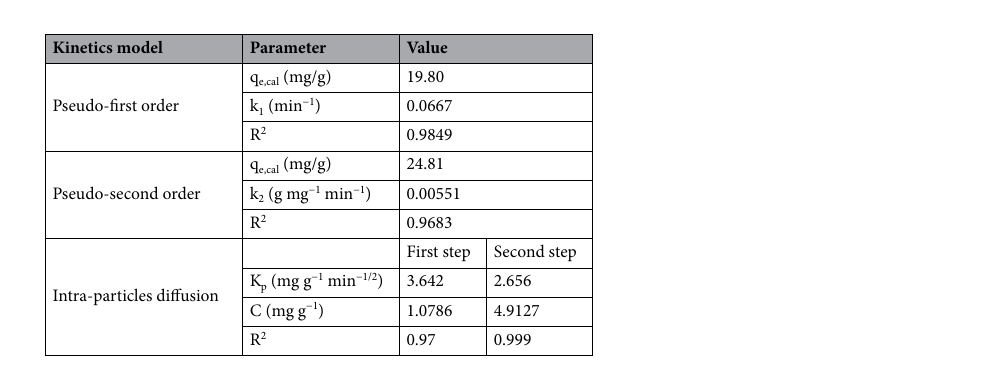
Table 3. The parameters of kinetics models for adsorption of CR dye onto K@AM-CTS composite